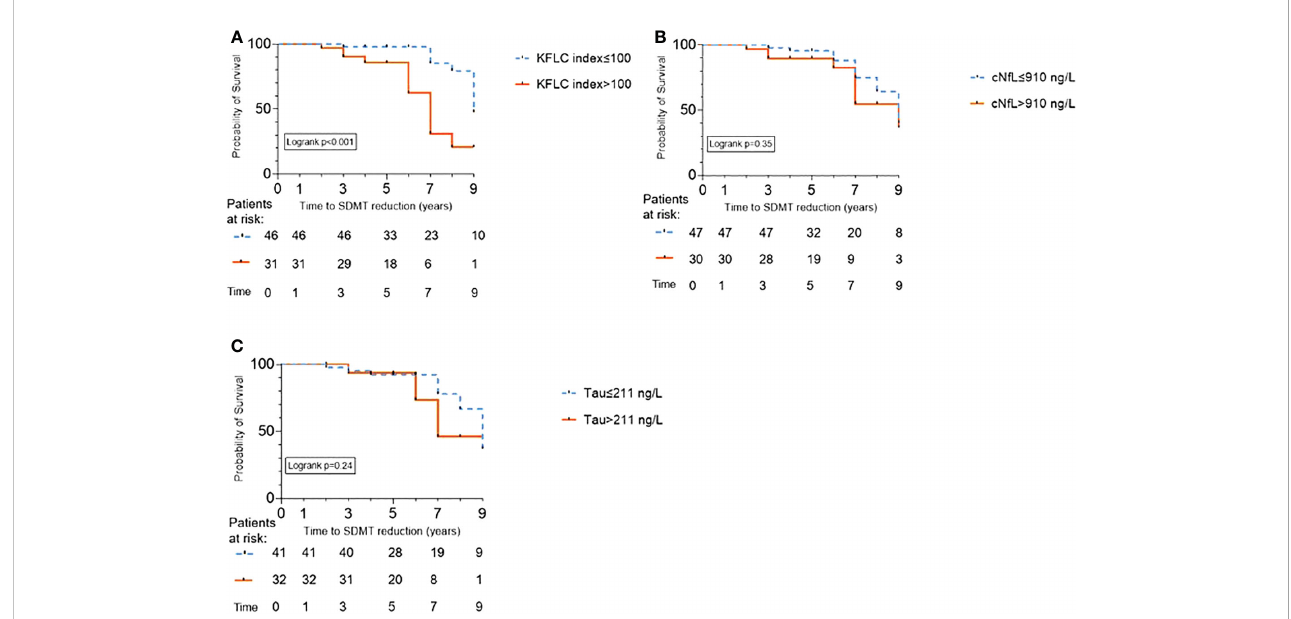
FIGURE 2 Kaplan-Meier survival curves showing time to information processing speed (IPS) worsening as predicted by cerebrospinal fl uid biomarkers in patients with relapsing-remitting multiple sclerosis. IPS was measured by symbol digit modalities test (SDMT) reduction. SDMT reduction of ≥ 8 points compared to baseline was considered signi fi cant. Analysis of the biomarkers were performed at the time of diagnosis. A total of 77 patients were strati fi ed according to: (A) The cut-off kappa free light chain (KFLC)-index>100 calculated as the 4th quintile, resulting in 31 patients in this group and 46 with KFLC-index ≤ 100; (B) The cut-off cerebrospinal fl uid neuro fi lament light (cNfL) >910 ng/L calculated as the 4th quintile, resulting in 47 patients with cNfL ≤ 910 ng/L and 30 with cNfL>910 ng/L; And (C) The cut-off cerebrospinal fl uid Tau>211 ng/L, resulting in 41 patients with Tau ≤ 211 ng/L, and 32 patients with Tau>211